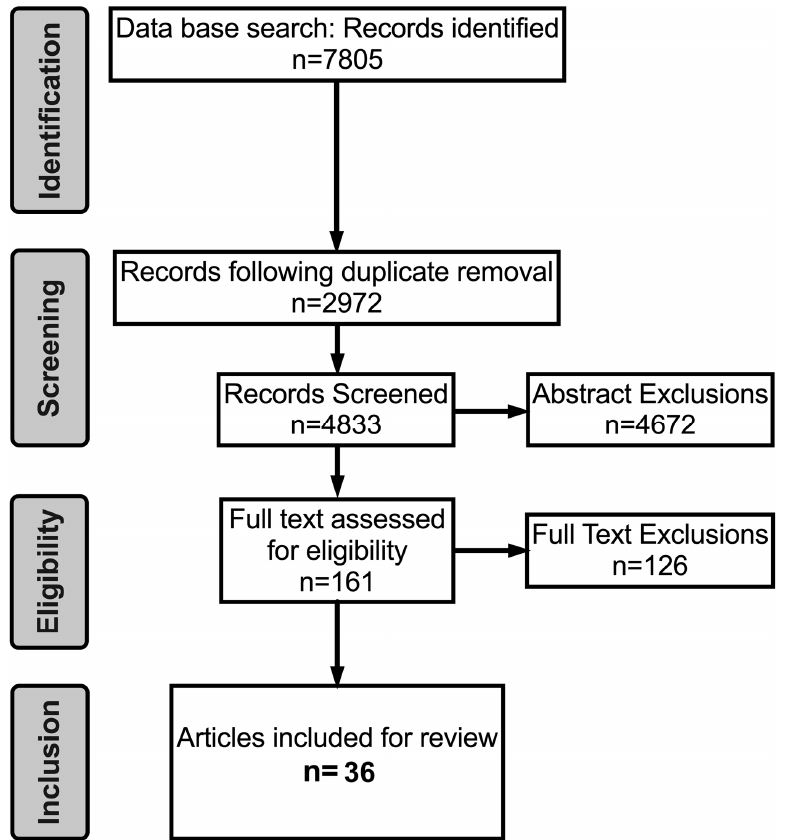
Figure 4. Flow chart demonstrating the identification, screening, eligibility and inclusion of articles identified for phase 2 (exercise and cognition) of the dual systematic review in accordance with PRISMA